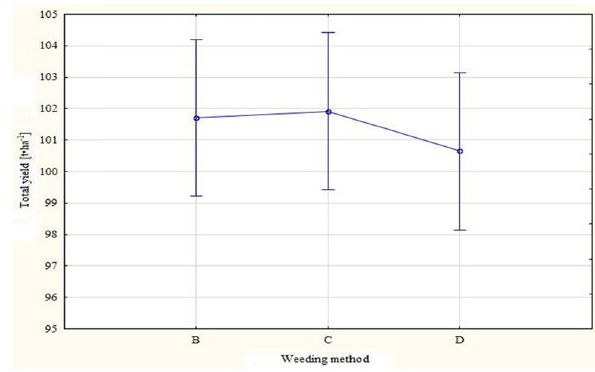
Figure 12: The expected marginal averages for 0.95 con fi dence intervals for total yield according to the various methods of weeding carrots in 2018 ( source: own work ) .